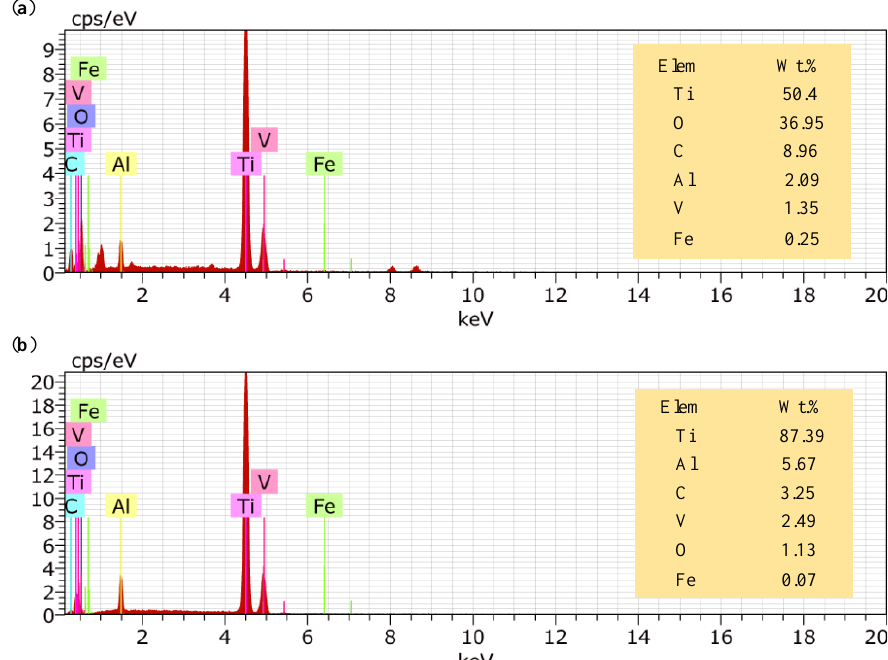
Figure 12. Energy spectrum analysis of groove surface after ( a ) rough machining, ( b ) finish